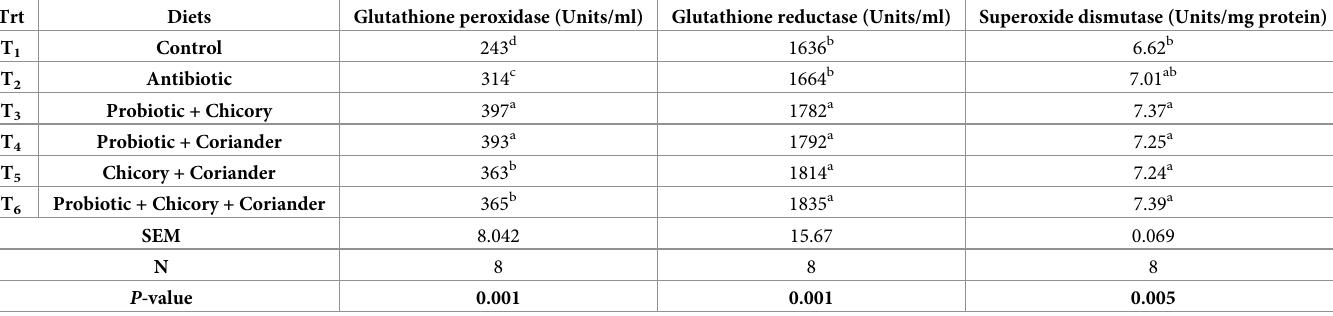
Value bearing different superscripts within a column are significantly (P < 0.05)